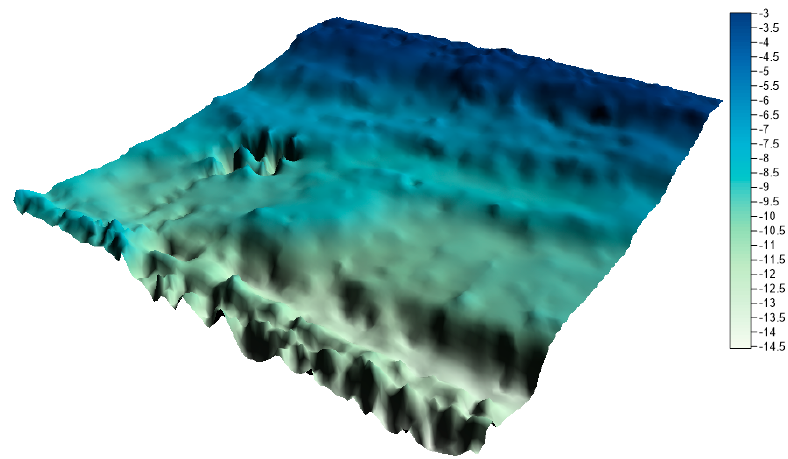
Figure 12. Surface obtained by integrated dataset no. 2 for the LNG port area.